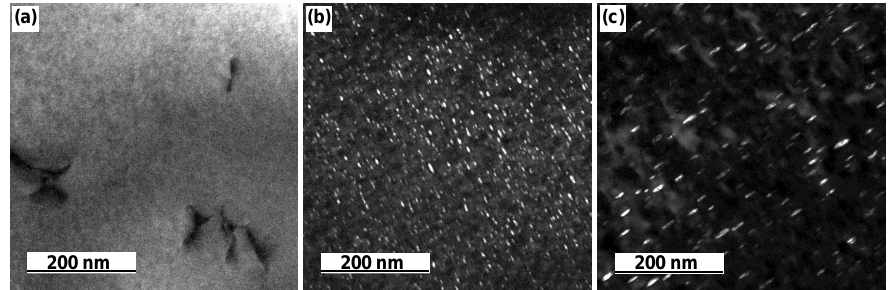
Figure 1. Dark field TEM micrographs showing the precipitation distribution in the ( a ) SA, ( b ) AR, and ( c ) OA